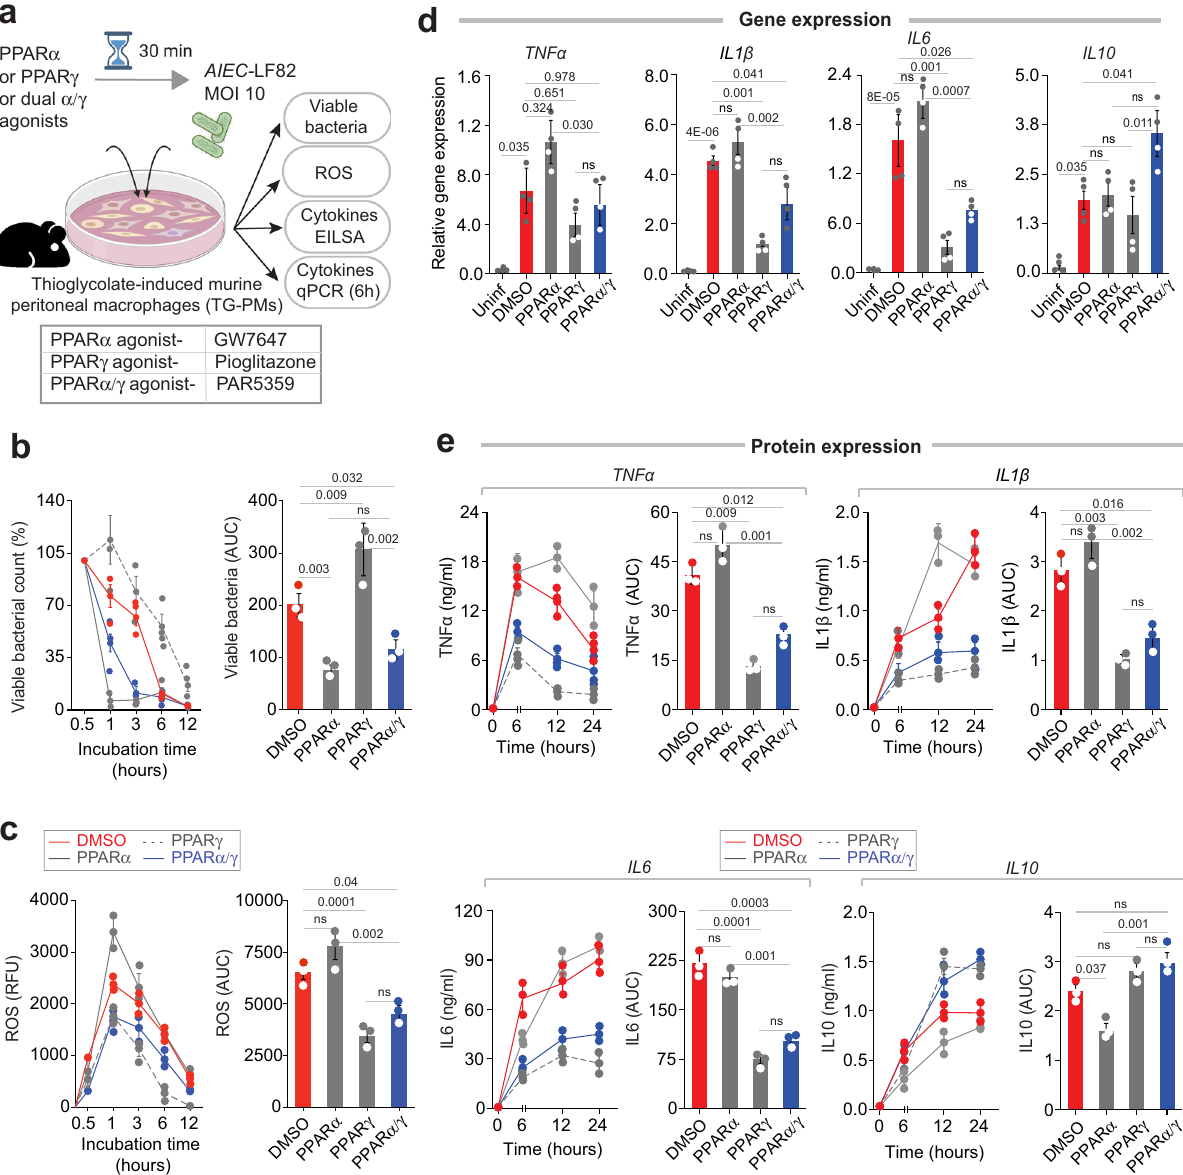
Fig. 5 PPAR α and PPAR α / γ -dual agonists enhance, whereas PPAR γ agonist delay bacterial ( AIEC -LF82) clearance. a Schematic displays the experimental design and work fl ow. Thioglycolate-induced murine peritoneal macrophages (TG-PM) pretreated with PPAR agonists (see box, below; 20 nM GW7647, 10 μ M Pioglitazone and 1 μ M PAR5359) were infected with AIEC -LF82 ( MOI 10) and subsequently analyzed for the bacterial count (Gentamicin protection assay), generation of cellular ROS, secretion of in fl ammatory cytokines (in supernatant media by ELISA) and the induction of cytokines (gene transcript analysis by qPCR, the cycle threshold (Ct) of target genes was normalized to 18S rRNA gene and the fold change in the mRNA expression was determined using the 2 − ΔΔ Ct method). b Line graphs (left) display percent viable bacterial counts at indicated times after infection. Bar graphs (right) display the AUC. c Line graphs (left) and bar graphs (right) display the extent of ROS generation over time. d Bar graphs display the relative expression of transcripts of multiple cytokines ( IL1 β , IL6 , TNF α , and IL10 ). All results are displayed as mean ± SEM. ( n = 3). Signi fi cance: n.s, not signi fi cant, p -value < 0.05 was considered signi fi cant. e Line graphs (left) and bar graphs (right) showing the levels of indicated cytokines secreted in the media. Statistics: All results are from at least three independent experiments and results displayed as means ± SEM. Signi fi cance was tested using two-way/one-way ANOVA followed by Tukey ’ s test for multiple comparisons. All results are displayed as mean ± SEM. ( n = 3). Signi fi cance: ns, non-signi fi cant, p -value < 0.05 was considered signi fi cant. See Supplementary Fig. 11 for similar bacterial clearance assays performed using Salmonella enterica